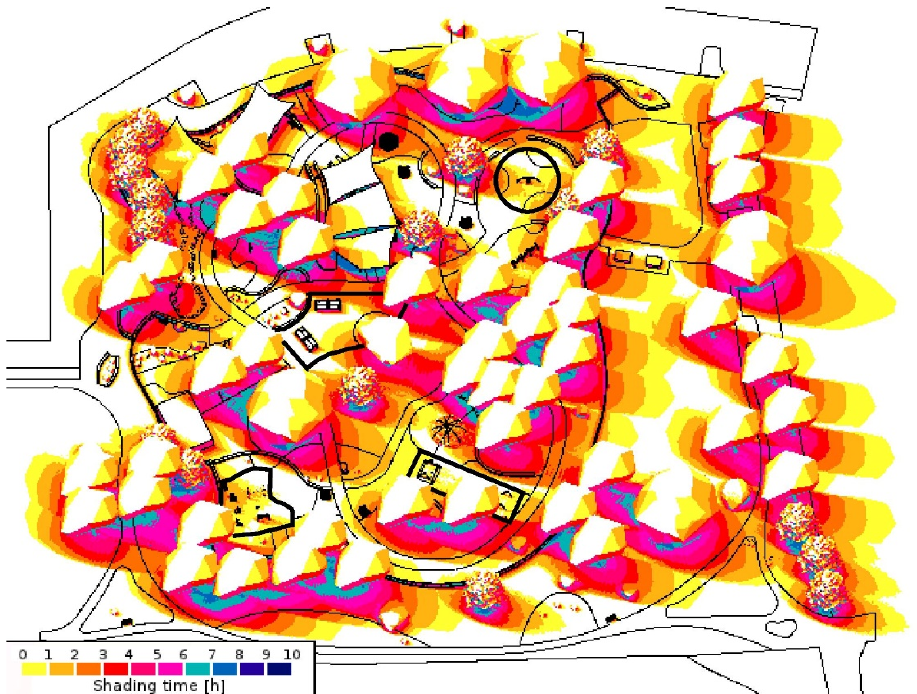
Figure 15. Summer solstice: 21 December (fourteen total daylight hours per